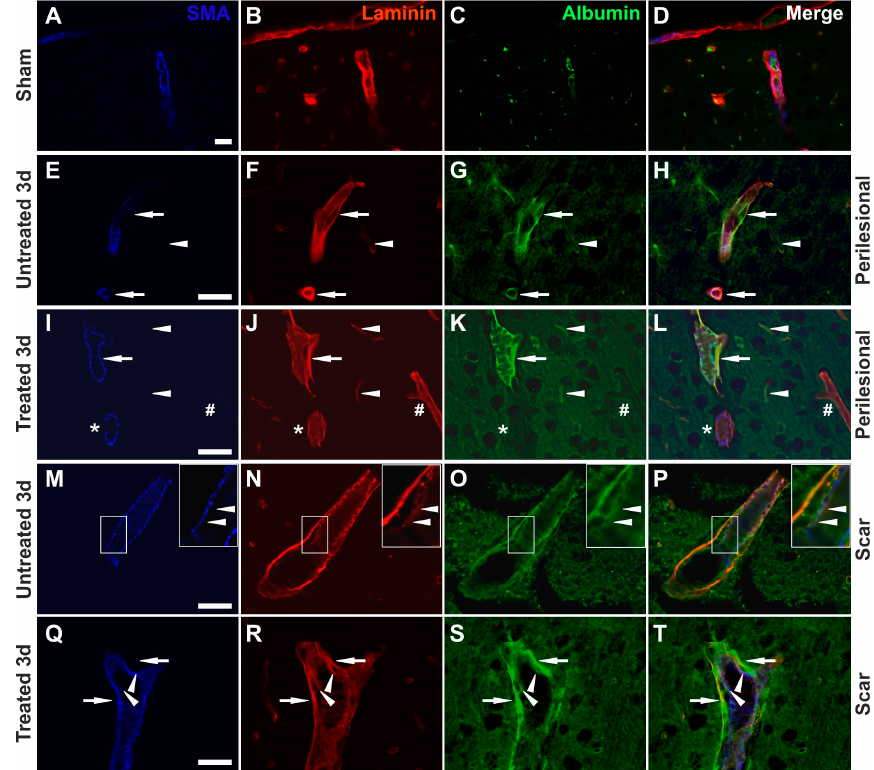
Figure 5. Increased retention of albumin along the vascular basement membranes. ( A – D ) An exemplary image from a sham animal shows endogenous rat albumin being present only in the vascular lumen for an arteriole (SMA-positive) and surrounding capillaries; ( E – H ) In untreated MCAO animals, arterioles (arrows) and capillaries (arrowhead) show albumin colocalizing with laminin on their basement membranes, and frequently these basement membranes with albumin deposits are thickened (arrows); ( I – L ) In TGN-020-treated MCAO animals, arterioles (arrow) and capillaries (arrowheads) also show albumin colocalizing with laminin in their external basement membranes, and these basement membranes with albumin deposits are even thicker here (arrow). Not all SMA-positive (*)/SMA-negative (#) vessels have albumin deposits; ( M – P ) Albumin colocalization occurs in arterioles in the exterior basement membranes, and less in those of the tunica media and under the endothelium (arrowheads), ( Q – T ), but to a lesser extent than in the external basement membranes for the treated animals (arrowheads versus arrows). Scale bars in the micrographs represent 40 µm.